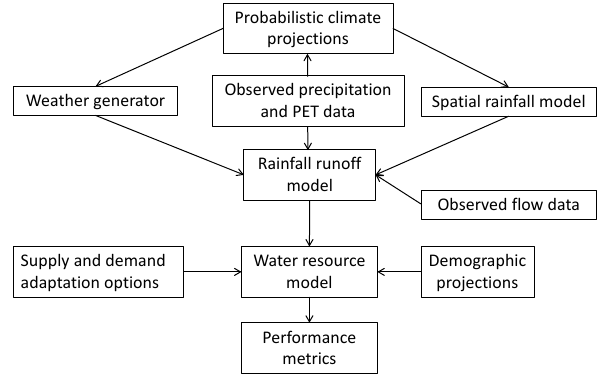
Figure 1. Methodological approach for the study of current and fu- ture water resources for the